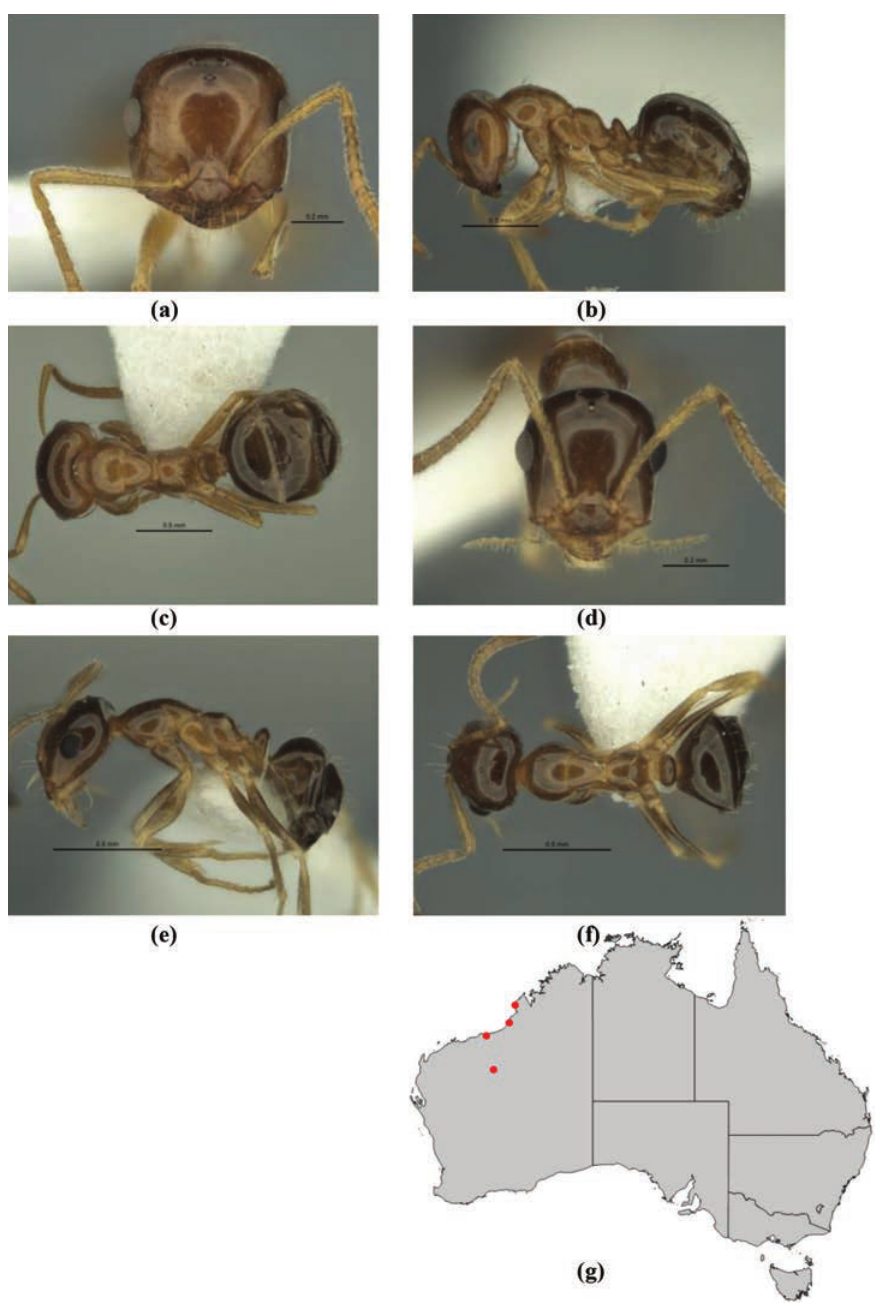
Figure 37. Melophorus gracilis sp. n.: major worker paratype (ANIC32-900209–bottom ant) frons ( a ), profile ( b ) and dorsum ( c ); minor worker holotype (ANIC32-900209–middle ant) frons ( d ), profile ( e ) and dorsum ( f ); distribution map for the species ( g ). Low resolution scale bars: 0.5 mm ( b, c , e, f ); 0.5 mm ( a, d